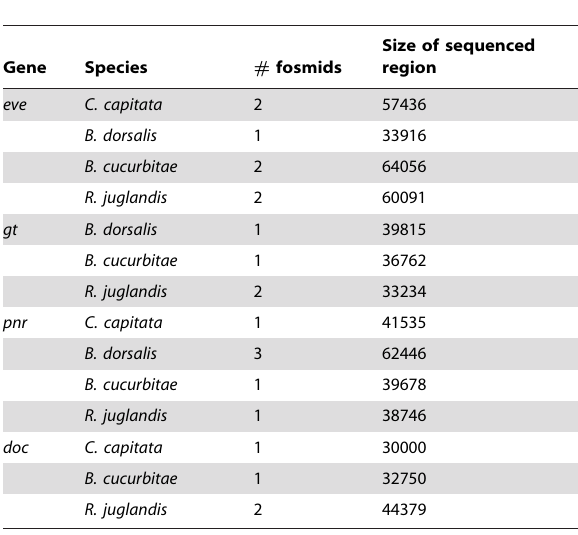
Table 1. Loci sequenced for this study.